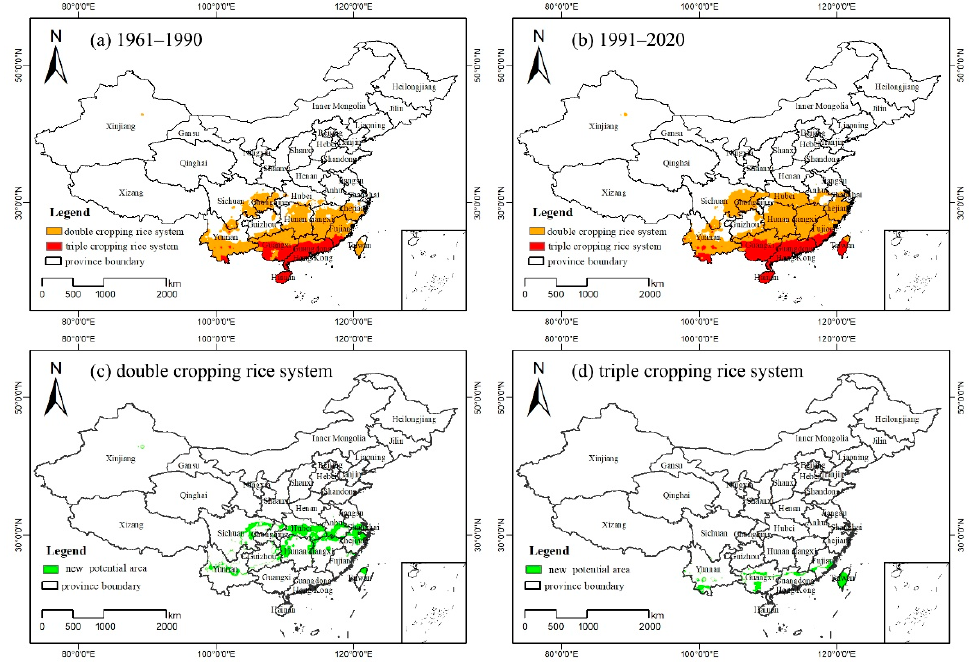
Figure 10. Potential suitable planting area of double rice cropping system (orange region) and triple rice cropping system (red region) during the period of ( a ) 1961–1990 and ( b ) 1991–2020, and new potential area of ( c ) double rice cropping system and ( d ) triple rice cropping system.